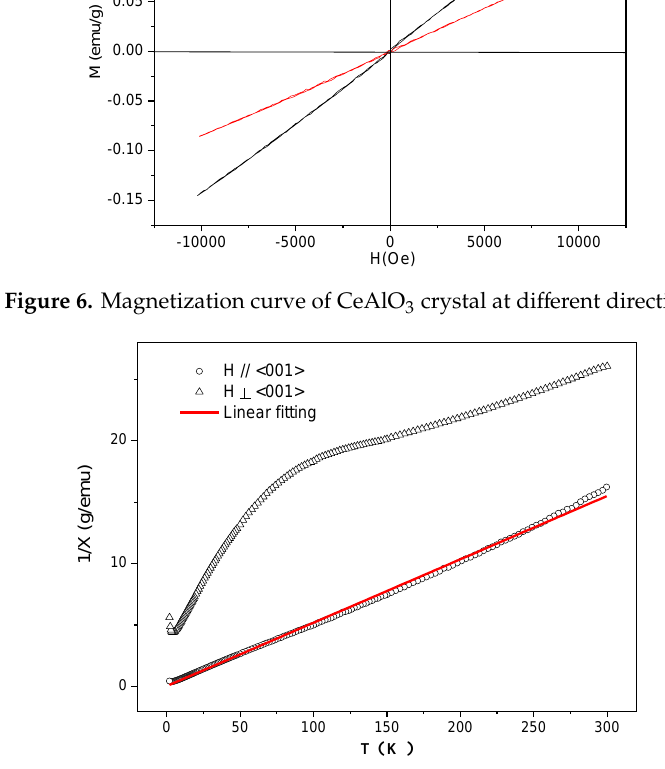
Figure 7. Temperature dependencies of the inverse magnetic susceptibility of CeAlO 3 crystal at different directions.